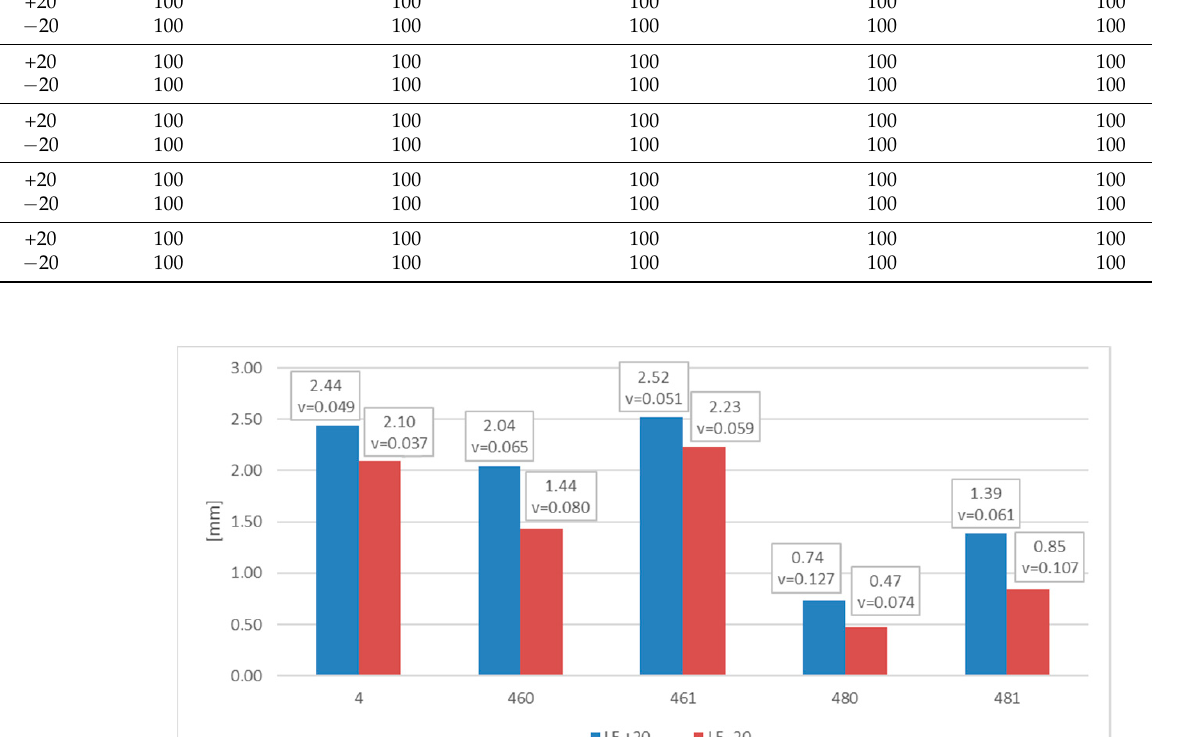
Figure 24. Averaged values of the LE parameter and corresponding coefficients of variation (estimated on a statistical sample) obtained on impact toughness test samples made of X2CrNiMoN22-5-3 steel.